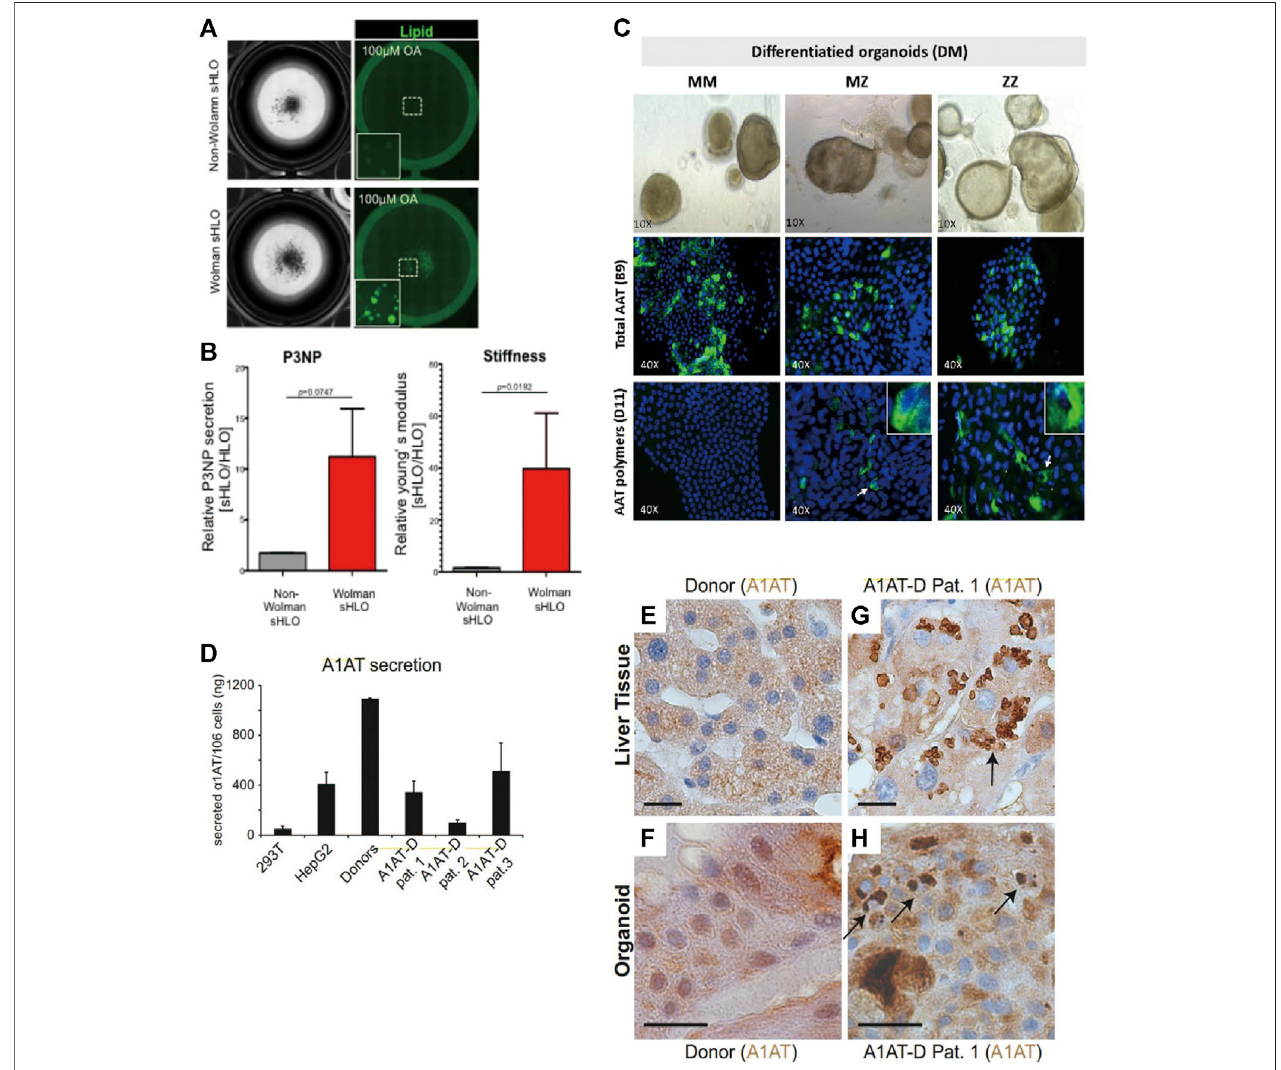
FIGURE 4 | Selected representative 3D models of monogenic diseases. (A) Representative bright- fi eld and lipid- fl uorescent images of organoids from Wolman disease patients and non-Wolman donors after oleic acid treatment. (B) (Left) Comparison of the P3NP secretion level of non-Wolman and Wolman human liver organoids (HLOs). (Right) Comparison of Young ’ s modulus of non-Wolman and Wolman organoids, n (cid:1) 7. (C) Differentiated liver organoids from MM, MZ, and ZZ patients.Speci fi cdetectionoftotalAATproteinwithanti-AAT-B9andAATpolymerswithanti-AAT-D11isshowningreen fl uorescence. (D) ELISAmeasurementof A1ATsecretioninsupernatantsfromhealthydonorandpatientorganoidsafter11 daysofdifferentiation. (E – H) ImmunohistochemistryforA1ATonlivertissue (E,G) and liver-derivedorganoidsfromahealthydonor (F) andarepresentativeA1ATde fi ciencypatient (H) .BlackarrowsindicateA1ATproteinsaggregatedinpatient-derivedliver tissue (G) and organoids (H) . Scale bars, 20 mm. All results are represented as mean ± SEM. Figure modi fi ed with permission from Ouchi et al. (2019), Gomez-Mariano et al. (2020), and Huch et al. (2015).